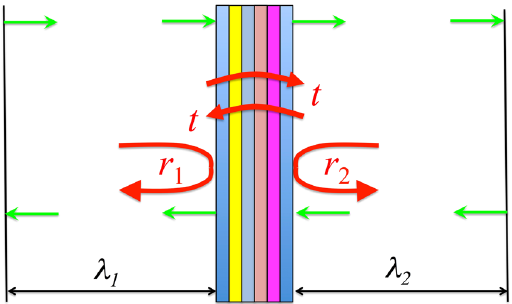
Figure 5. Illustration of S-quantization formalism: layered structure in the quantization